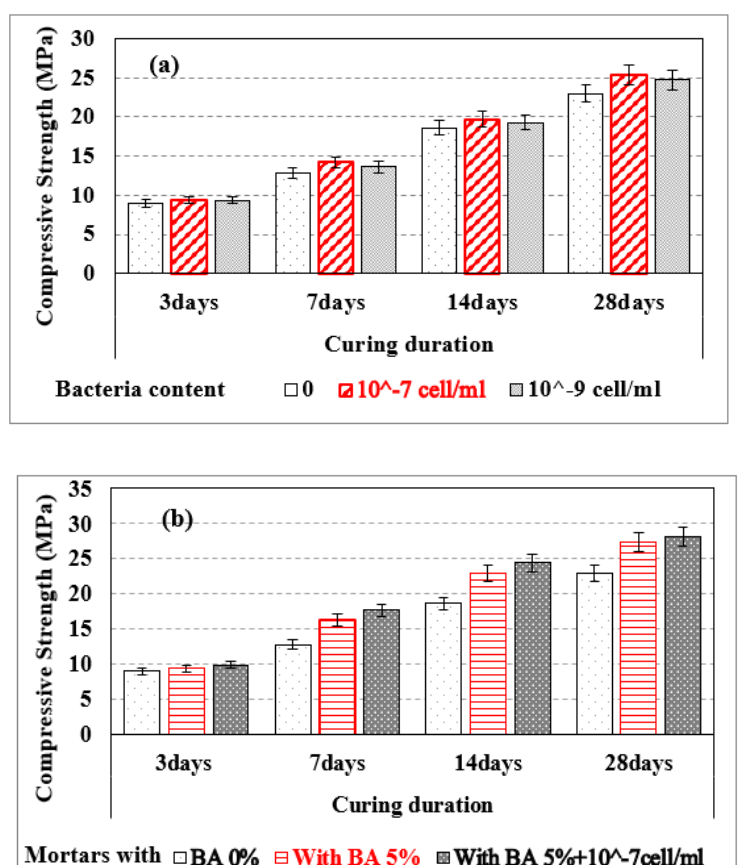
Figure 12. Compressive strengths of samples: ( a ) conventional mortar (BA 0%) and SHM with different bacteria cell/mol; ( b ) conventional mortar sample (BA 0%), SHM sample with 5% BA, and SHM with 5% BA w, Bacteria 10 − 7 cell/mL.